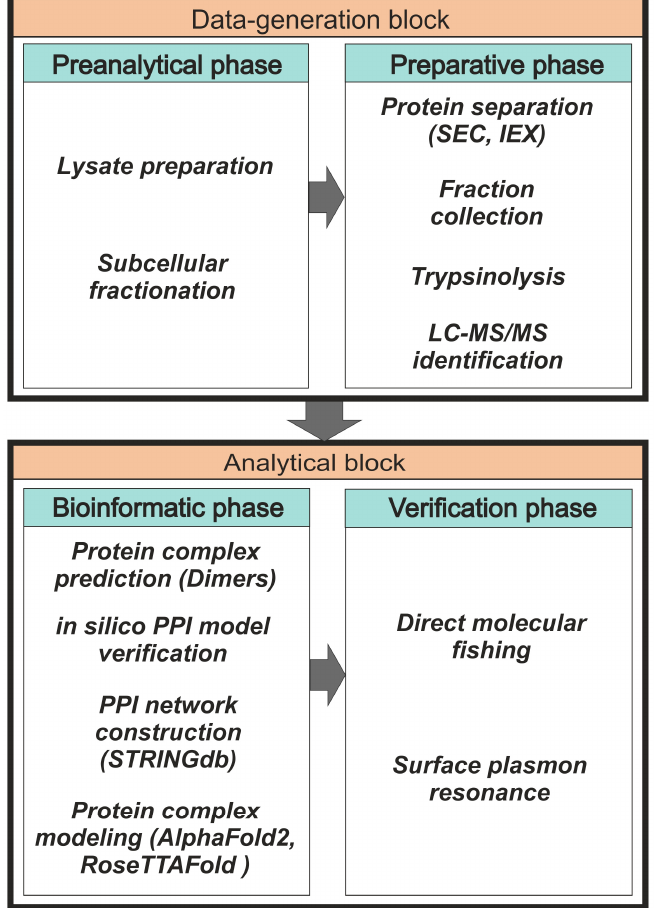
Figure 1. The general scheme of the panoramic-interactome-profiling